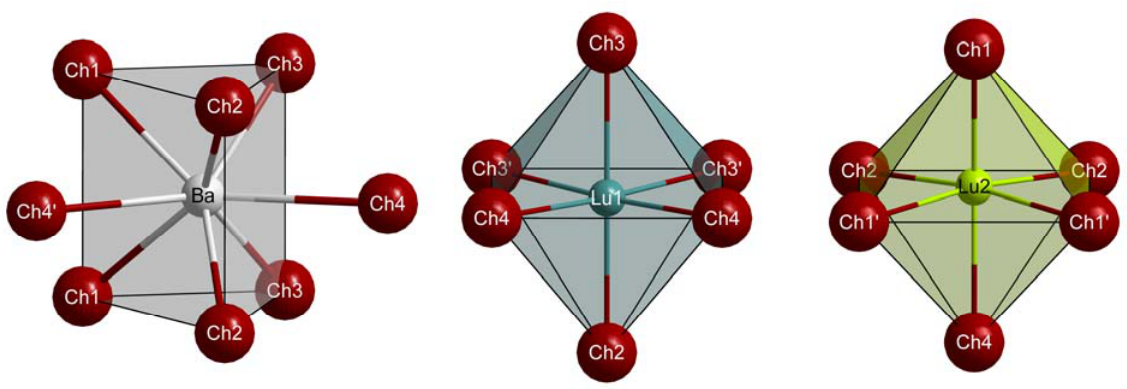
Figure 1. View at the coordination sphere of the Ba 2+ ( left ), (Lu1) 3+ ( mid ) and (Lu2) 3+ cations ( right ) in the crystal structure of the BaLu